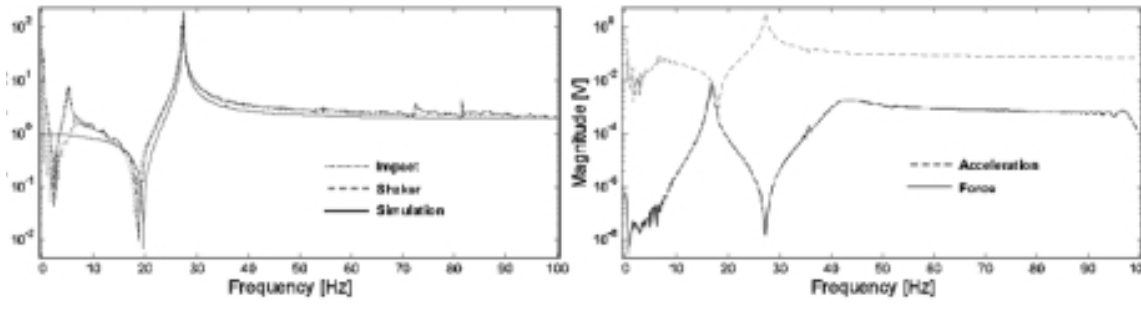
Fig. 13. (a) Driving point FRFs for a free-free 2DOF system (b) Driving point acceleration and the input